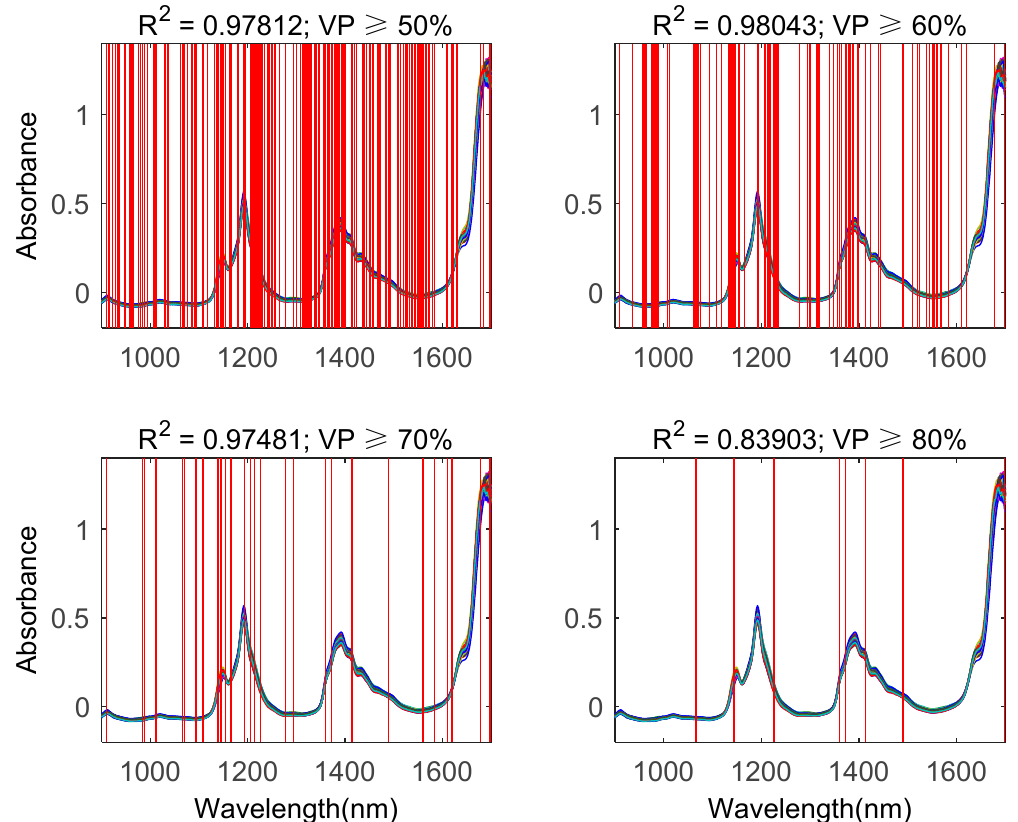
Figure 6. Wavelength selection results by using the multi-BDA method. VP: votes percentage. Upper left, upper right, lower left, and lower right represent selected wavelengths while the votes percentage is equal to or greater than 50%, 60%, 70%, and 80%, respectively.